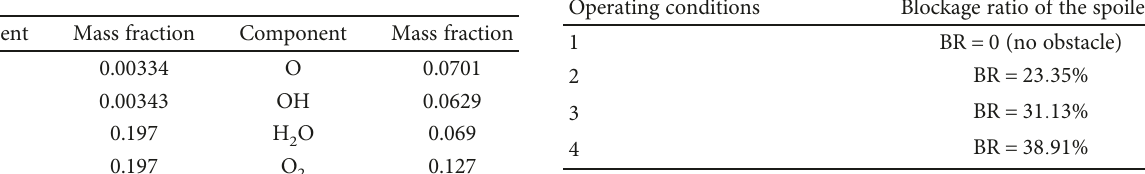
Table 4: Species and related mass fractions during adiabatic equilibrium phase of ethylene.